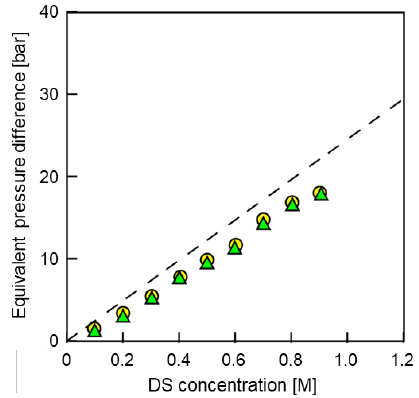
Figure 7. Equivalent pressure differences in the PRO process as a function of CDS. Circles, the applied pressure difference at the maximum power density; triangles, the half value of Δ P at zero water flux obtained from the J w -Δ P curve (1/(2Δ P Jw=0 )); dashed line, the half value of Δ π between DS and FS (Δ π /2). PRO conditions: FS, tap water; Q DS,in : 4.0 L/min; Q FS,in ; 1.5 L/min.